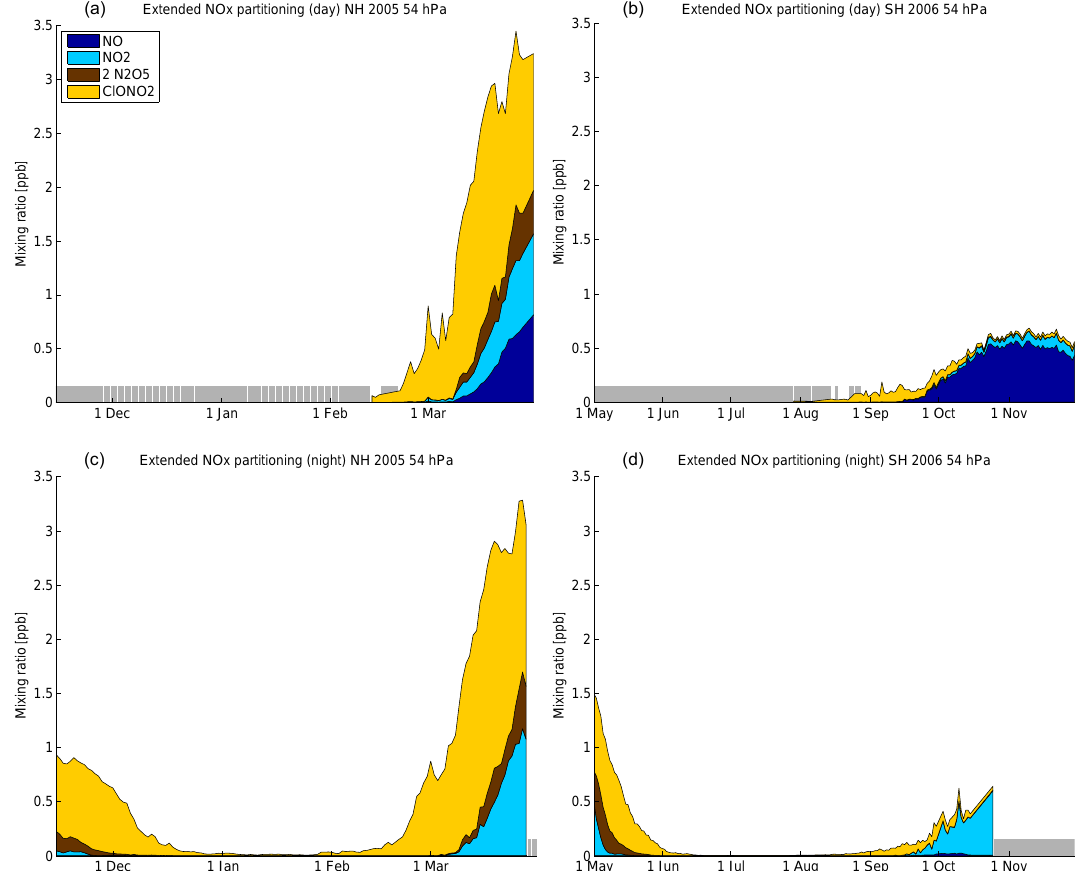
Figure 5. Vortex-averaged partitioning of extended NO x species for the Arctic winter 2004–2005 (a, c) and the Antarctic winter 2006 (b, d) at 54hPa. Panels (a, b) show daytime averages (parts of the vortex where the solar zenith angle is smaller than 80 ◦ ). Panels (c, d) show nighttime averages (parts of the vortex where the solar zenith angle is larger than 100 ◦ ). Days without sufficient data for averaging are not shown (grey